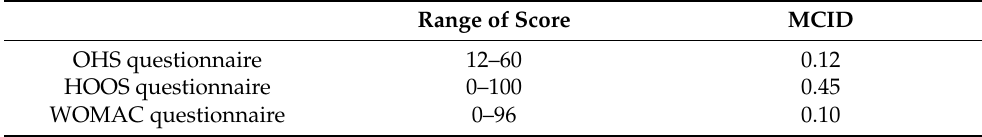
Table 4. Range of scores and minimal clinically important differences (MCIDs) of adopted